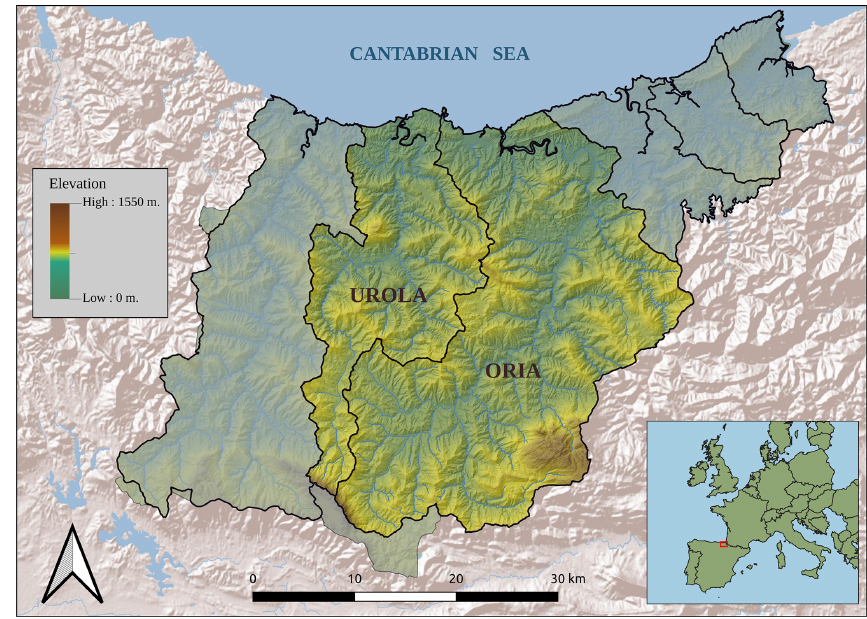
Figure 5. Location of the Gipuzkoa Province study area and the two river basins Urola and